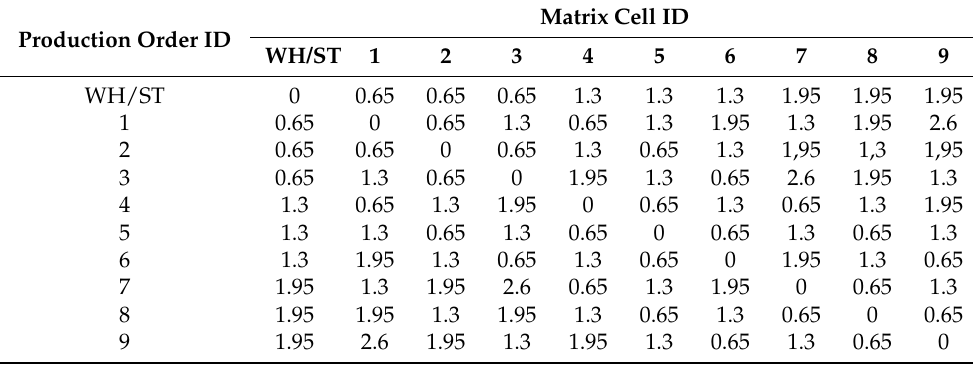
Table 6. Distances in the matrix grid [10